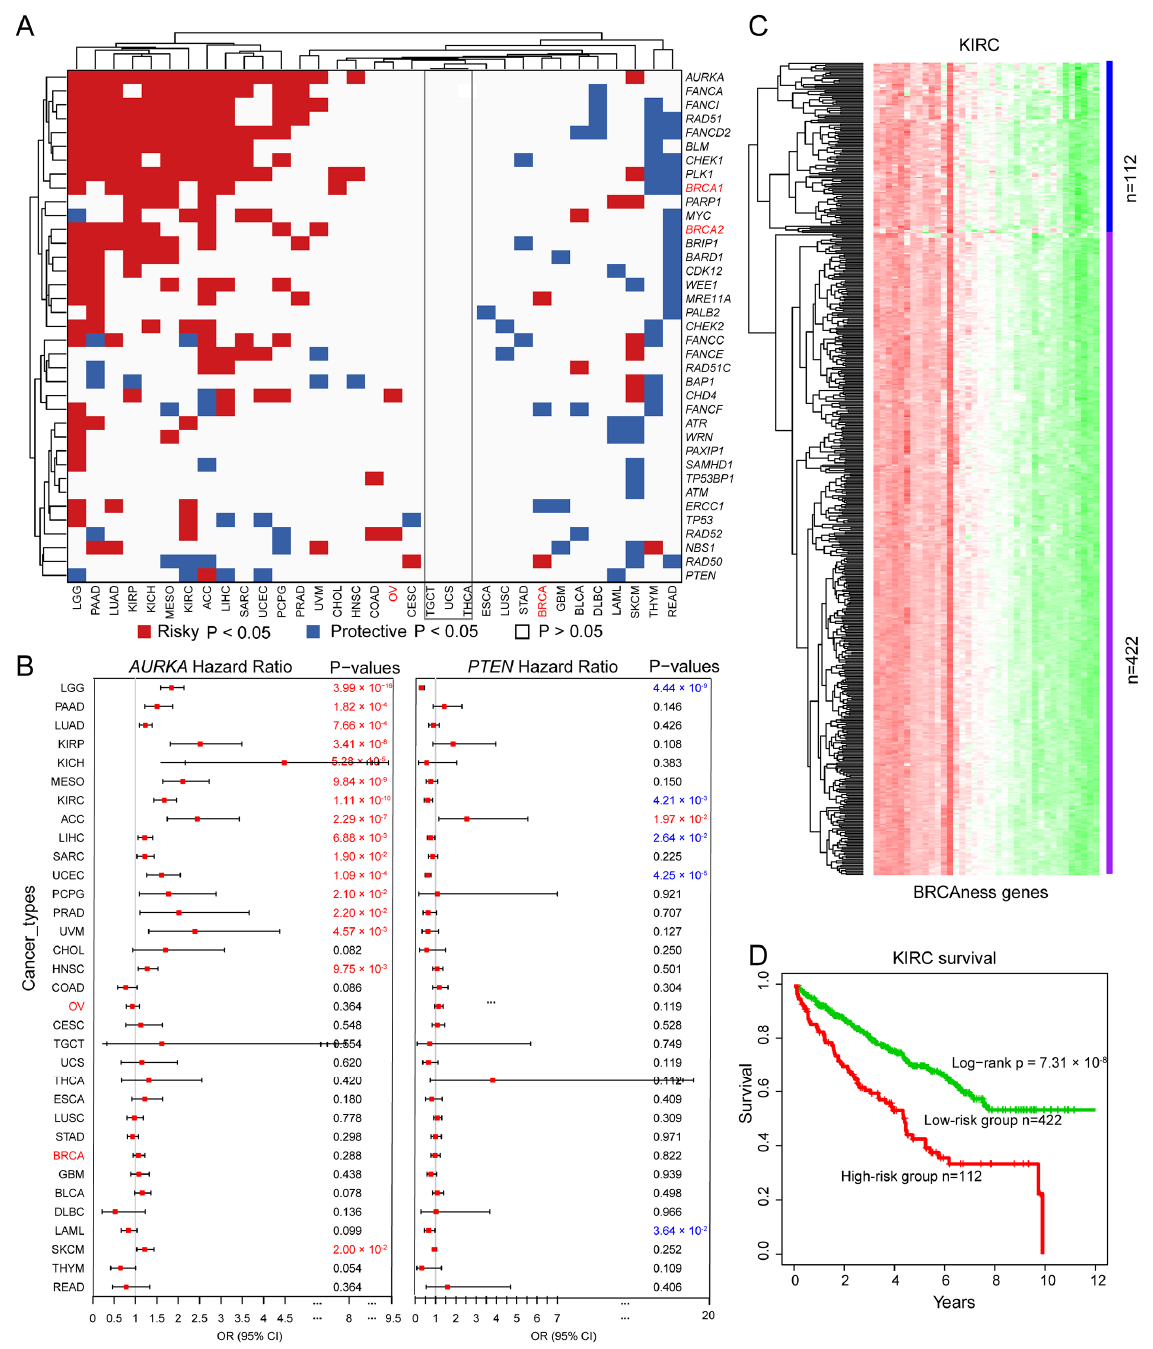
Figure 6. Clinical relevance of BRCAness genes across cancer types. ( A ) Correlation between expression of BRCAness genes and patient survival. OR, odds ratio; CI: confidence interval; Red p -values represents a higher expression of BRCAness genes associated with worse survival, and blue p -values represents an association with better survival. Only p values < 0.05 are shown. ( B ) Distribution of hazard ratios across different cancer types in AURKA and PTEN . Red: the cancer types for those the expression levels of AURKA or PTEN are risky factors; Blue: the cancer types for those the expression levels of PTEN are protective factors. ( C ) Heatmap showing the clustered expression of all BRCAness genes in KIRC cancer patients. Red, higher levels of gene expression; Green, lower levels of gene expression. ( D ) Kaplan–Meier survival plot of KIRC patients grouped by the altered expression patterns of BRCAness genes.